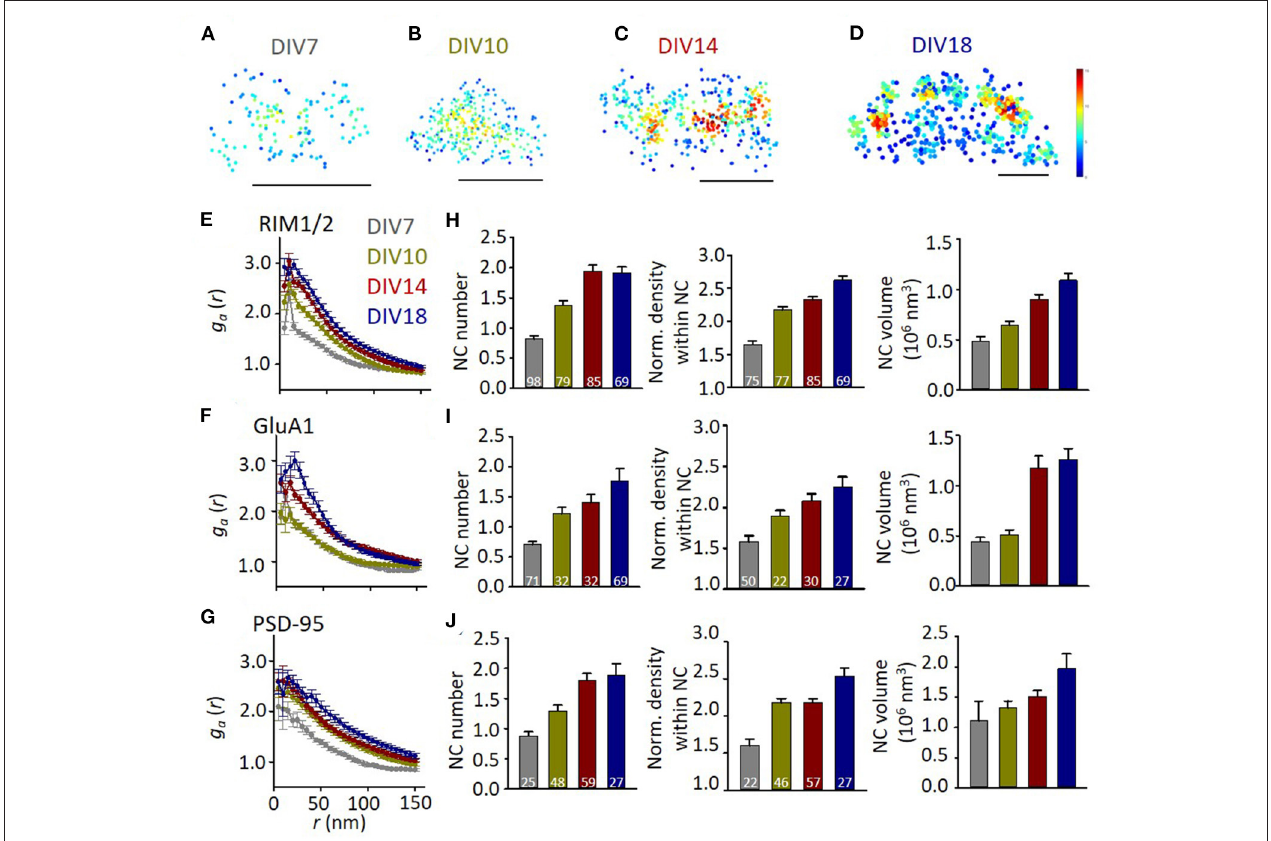
FIGURE 2 | The heterogeneity of synaptic protein distribution increases with development. (A–D) Representative density maps of synaptic GluA1 at different developmental stages. Scale bars, 200nm. (E–G) Normalized autocorrelation functions of RIM1/2 (E) , GluA1 (F) , and PSD-95 (G) . g a above 1 suggests a significant non-uniform distribution. (H–J) Developmental changes of nanocluster number (left), normalized density within nanocluster (middle), and nanocluster volume of RIM1/2 (H) , GluA1 (I) , and PSD-95 (J) . Numbers in bars denote the synapse numbers. Also refer to Supplementary Table 1 for more statistical details. All experiments were repeated ≥ 3